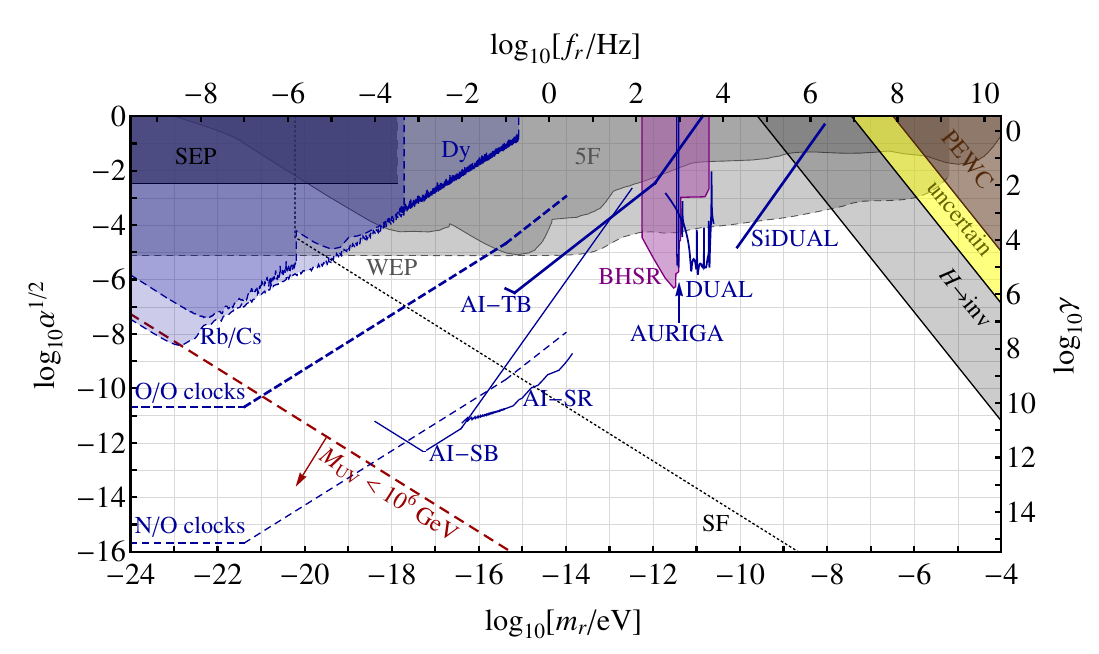
Figure 15 . Parameter space of the radion coupling (cid:11) 1 = 2 relative to gravity as a function of mass m r and frequency f r = m r = 2 (cid:25) . Under the assumption that the radion constitutes all of the dark matter, the discovery reach of scalar dark matter searches is shown by the blue curves. At sub-Hz frequencies, current optical clocks (O/O clocks) and a future nuclear-optical clock pair comparison (N/O clocks) have prime sensitivity [68]. Atom-interferometric gravitational wave detectors on earth (AI-TB) and in space (AI-SB) can cover frequencies between 10 (cid:0) 4 Hz and 10 Hz in broadband mode, while a space-based resonant-mode detector (AI-SR) could perform a deep scan above 10 (cid:0) 2 Hz [71]. Experimental proposals (DUAL [85], SiDUAL) based on resonant-mass gravitational wave detector technology can probe the radion above kHz frequencies [70]. 95%-CL limits from existing scalar dark matter searches by atomic clocks (Dy [72], Rb/Cs [73]) and the AURIGA resonant-mass detector [84] are indicated by blue regions. The radion can only be a subcomponent of DM left and below of the black dotted line due to disruption of structure formation (SF) [68]. Virtual radion exchange also leads to violations of the strong equivalence principle (SEP), which have been most strongly constrained by Doppler tracking of the Cassini spacecraft [63]. Curves and regions labeled \WEP", \Rb/Cs", \Dy", \O/O clocks", and \N/O clocks" assume that the relative radion couplings to di(cid:11)erent SM (cid:12)elds violate the weak equivalence principle by an (1) amount. Other O abundance-independent exclusion regions and M UV bounds are similar to those in (cid:12)gure